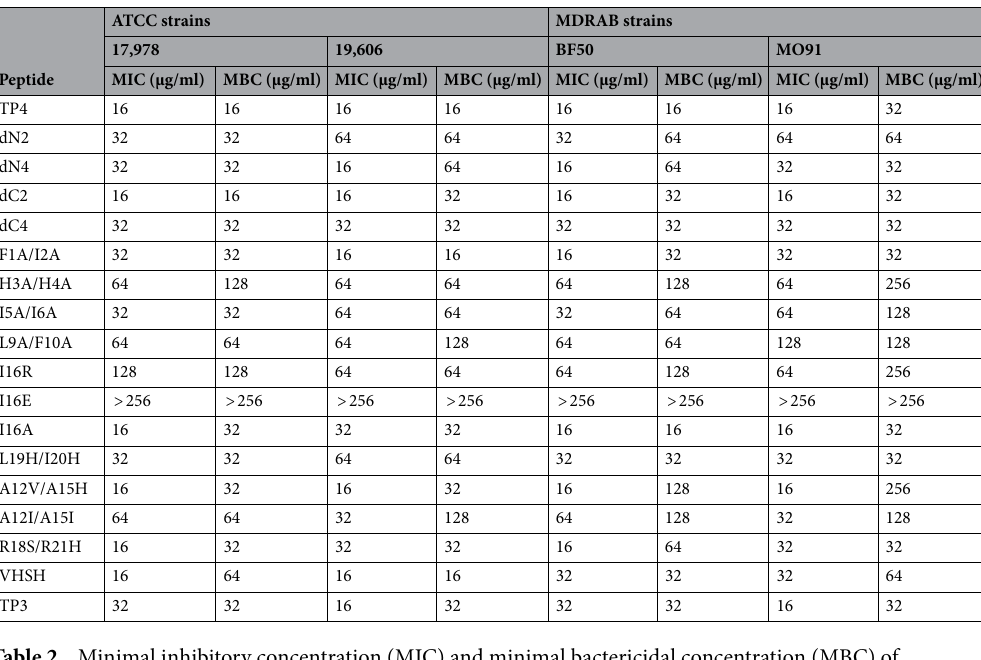
Table 2. Minimal inhibitory concentration (MIC) and minimal bactericidal concentration (MBC) of antimicrobial peptide TP4 derivatives against Acinetobacter baumannii ATCC and clinical multiple drug- resistant (MDR) strains.